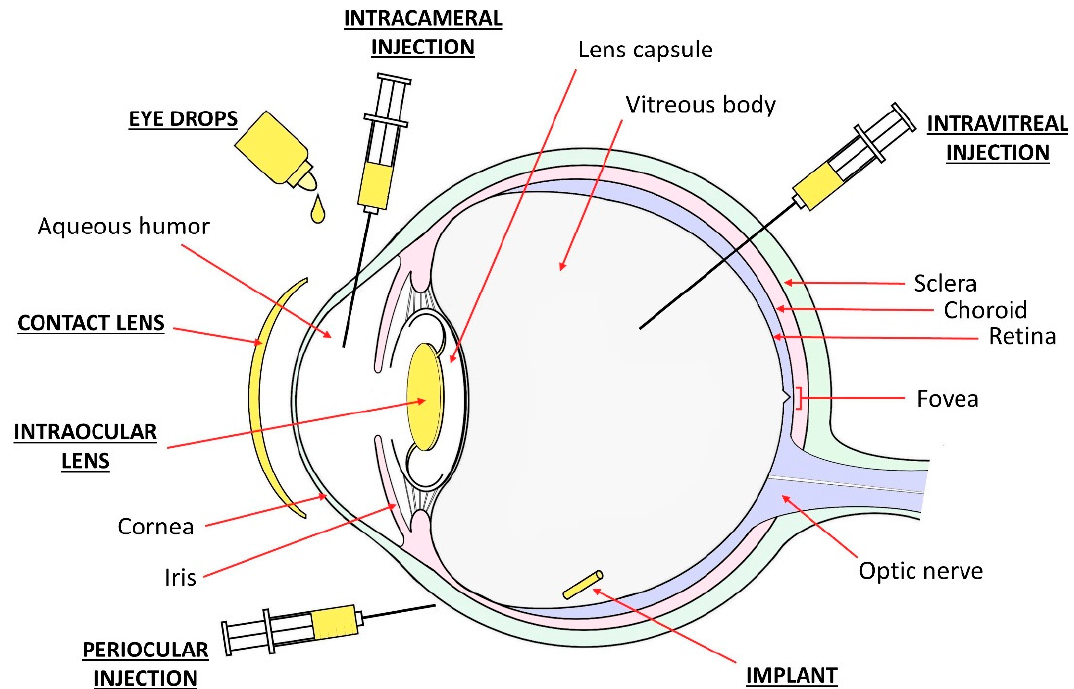
Figure 1. Ocular drug administration routes: eye drops, therapeutic contact lenses, therapeutic intraocular lenses, periocular injections (e.g., subconjunctival or sub-tenon injections), drug-eluting implant, intravitreal, and intracameral injec- tions.